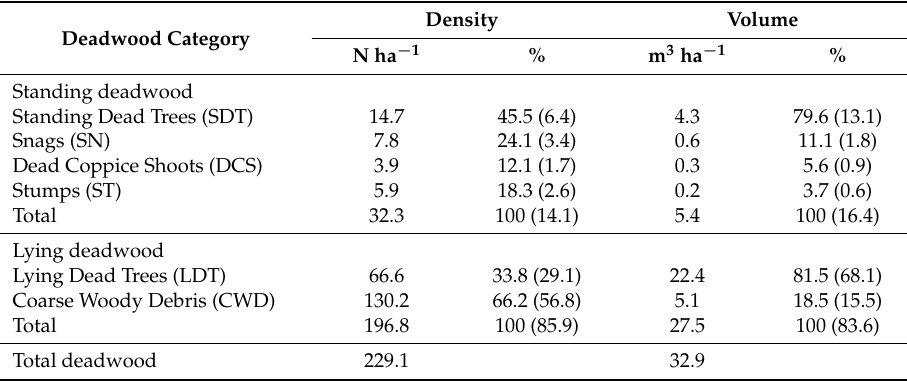
Table 3. Total number and volume of deadwood categories.